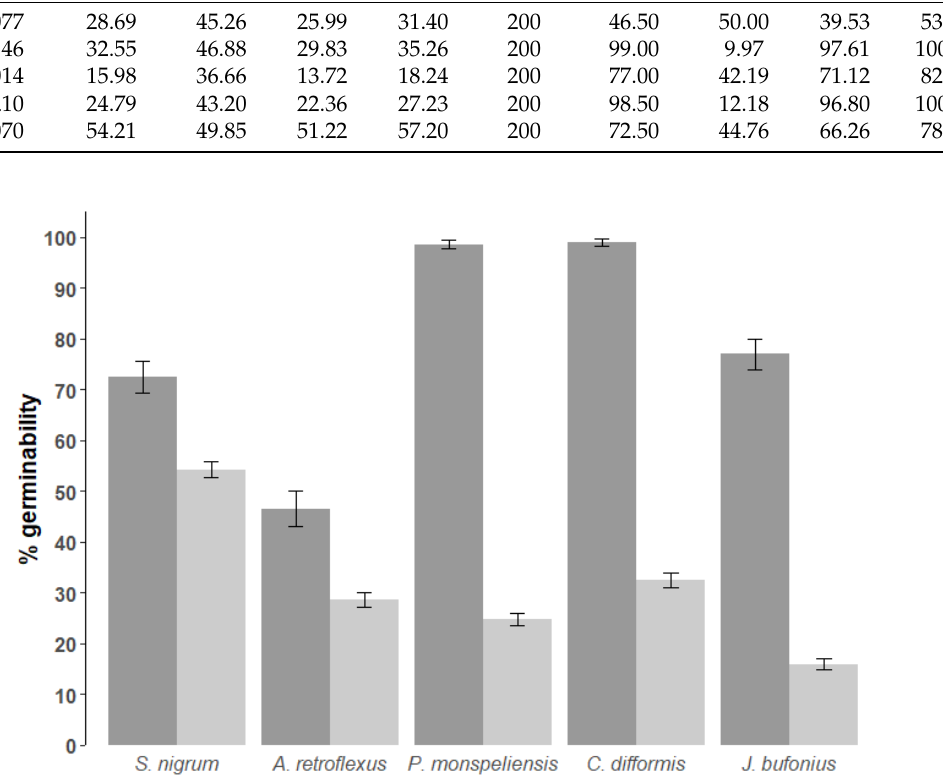
Table 4. Differences in germinability (percentage of seeds) after gut passage compared with control seeds. S.D.: Standard deviation. C.I.: 95% Confidence Interval. Experimental Seeds